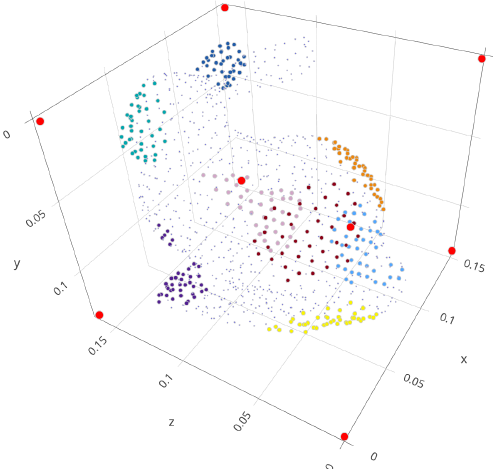
Figure 6. A demonstration of the corresponding closest points of each corner.